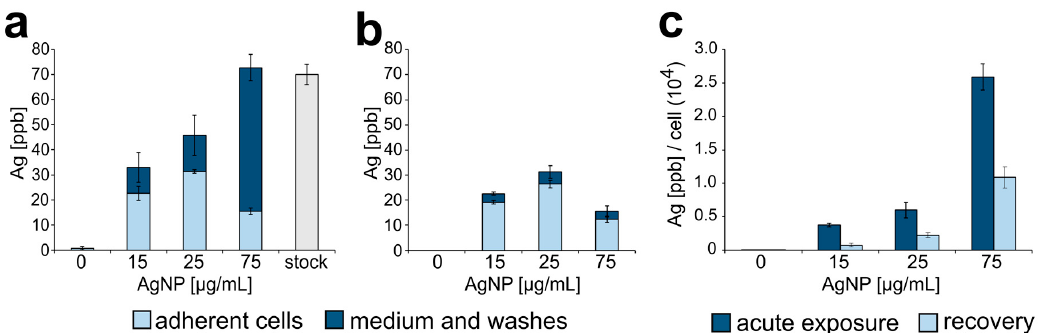
Figure 3. Silver nanoparticle intracellular accumulation. ( a ) Concentration of silver (ppb) found in adherent cells (light blue portion of bars) or in the extracellular medium (dark blue portion of bars) following acute exposure to AgNPs. The far-right grey bar shows the concentration of silver in a stock suspension of AgNPs prepared at a concentration of 75 µ g / mL. ( b ) Concentration of silver (ppb) found in adherent cells (light blue portion of bars) or in the extracellular medium (dark blue portion of bars) following a 24 h recovery period from acute exposure. ( c ) Silver concentration normalized to the number of adherent cells in each sample.